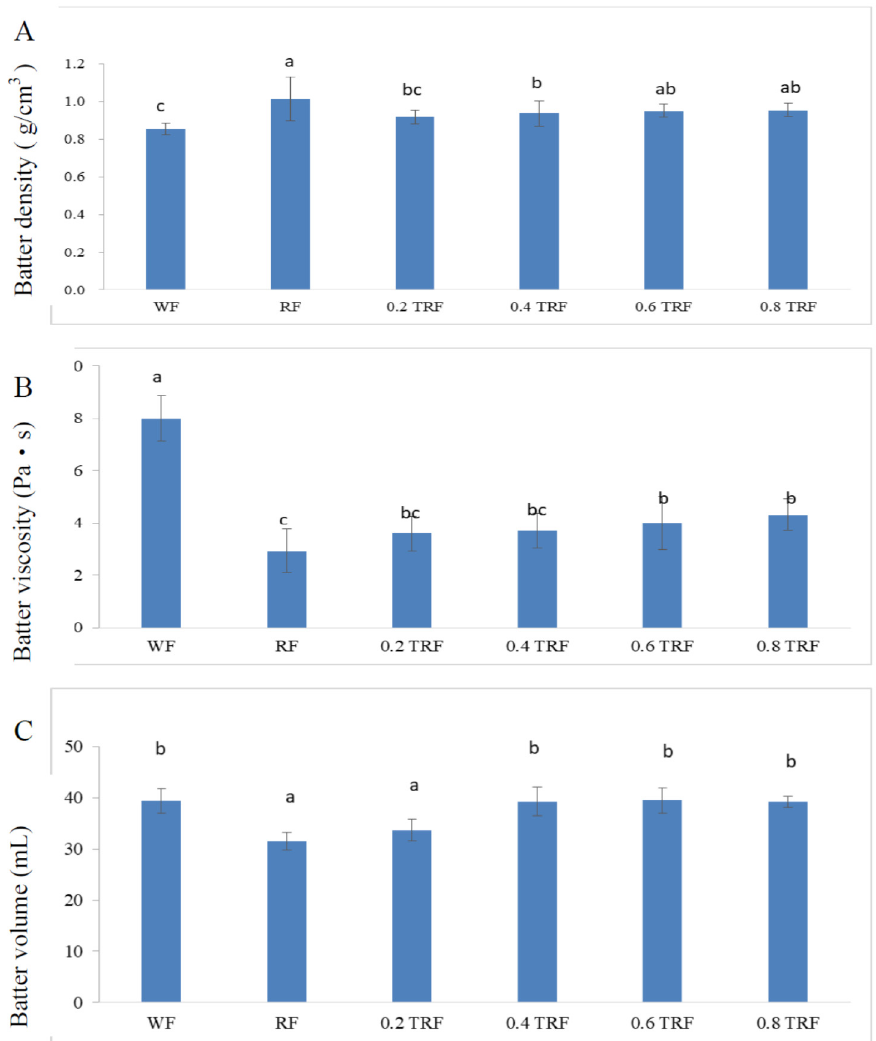
Figure 1. Comparison on batter density ( A ), batter viscosity ( B ), and batter volume ( C ) of gluten-free cake added with tamarind seed gum. a-b Di ff erent letters indicate significant di ff erence between di ff erent samples (n = 3; p < 0.05). WF: cake made with 100% wheat flour; RF: gluten-free cake supplemented with 100% rice flour; 0.2 TRF: gluten-free cake with 0.2% tamarind seed gum